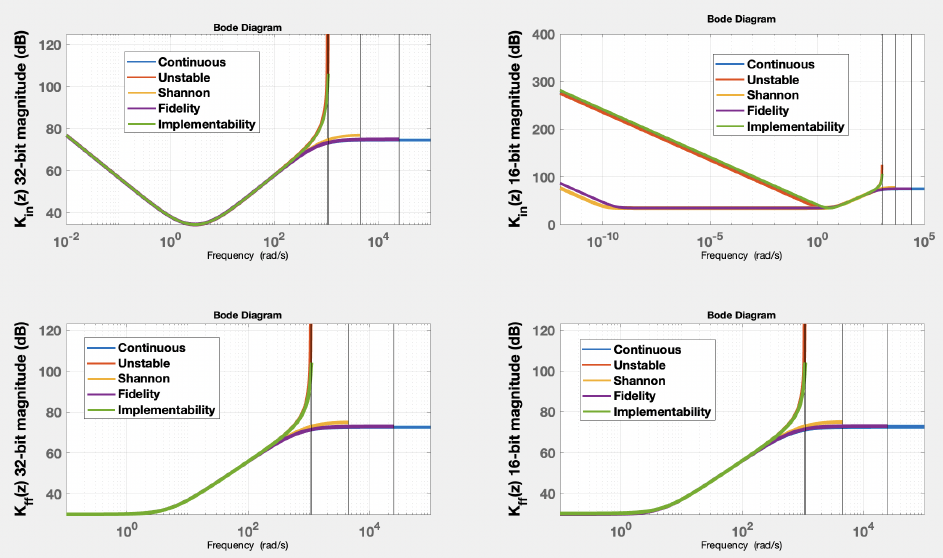
Figure 8. DC motor example regulator frequency magnitude responses; the first line gathers the inner regulator K in ( z ) with 32-bit and 16-bit quantized regulator coefficients, respectively, while the second line gathers the feedforward controller K ff ( z ) in the same 32-bit and 16-bit configurations. For completeness, the continuous-time ideal regulators K in ( s ) and K ff ( s ) were also added alongside their discrete-time